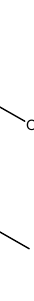
Figure 1. Chemical structures of active compounds 1 and 2.